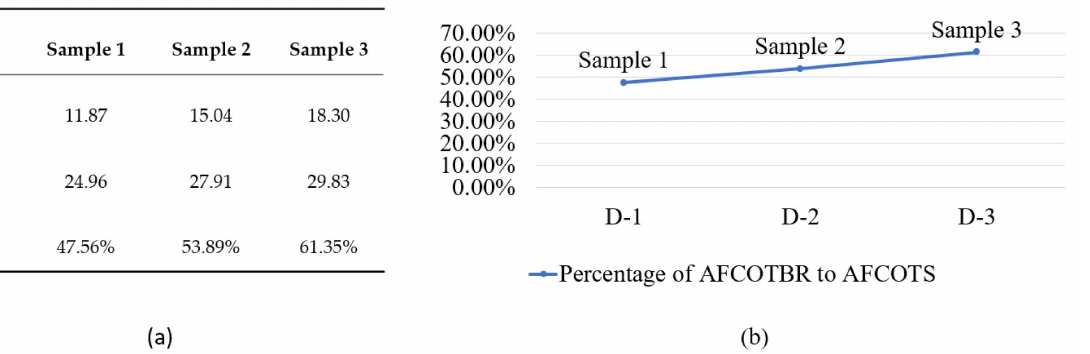
Figure 11. Analysis of the fixation points in the experiment 1: ( a ) Data related to the number of fixation points in the experiment 1 and ( b ) relationship between the percentage of AFCOTBR to AFCOTS, and distribution of building blocks (the experiment